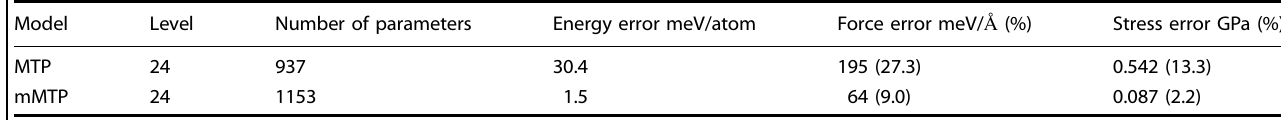
Table 1. The best non-magnetic and magnetic MTPs.